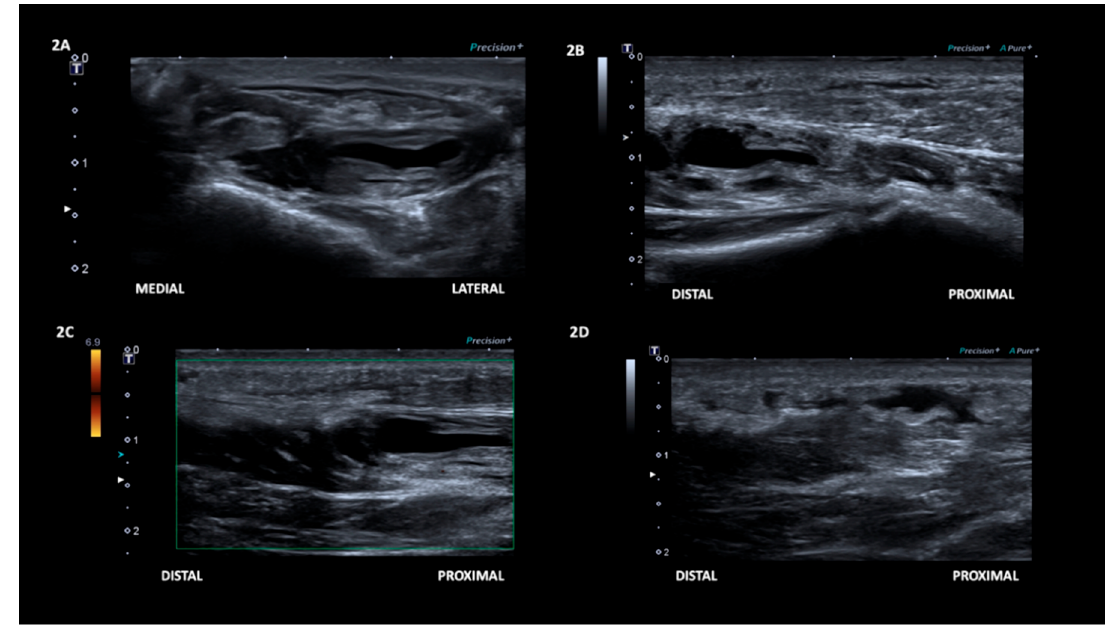
Figure 2. The initial ultrasound examination revealed an area of focal disruption of the fibrillary structure of the mid-portion of the flexor hallucis brevis muscle, shown in transverse axis ( A ), and longitudinal axis ( B ). No vascularity was observed with Power Doppler ( C ). Additionally, localized subcutaneous oedema in close proximity to the zone of muscle tear ( D ).